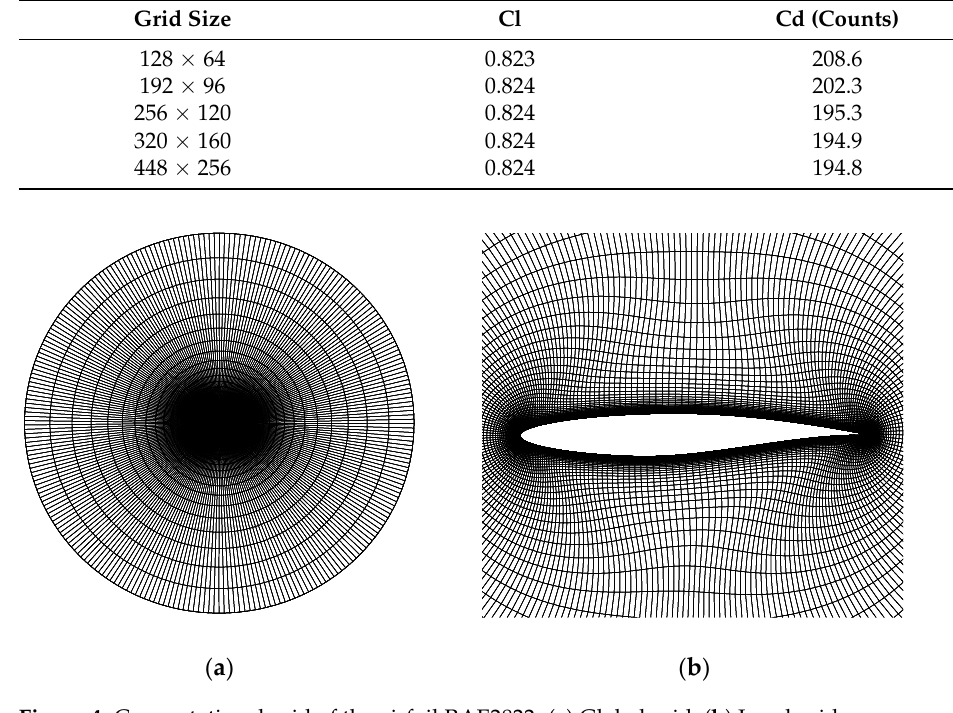
Figure 4. Computational grid of the airfoil RAE2822. ( a ) Global grid; ( b ) Local